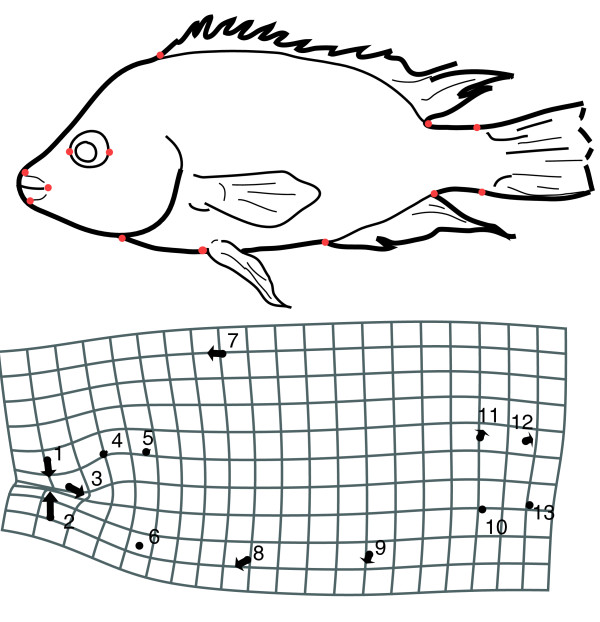
Body shape variation between thin-lipped and thick-lipped Apoyeque Midas cichlids. (a) The location of 13 landmarks to describe body shape. (b) Body shape differs significantly between thin- and thick-lipped fishes (P = 0.001). Here this is visualized (scale factor 4) as landmarks compared between the mean thick-lipped (circle; n = 36) and mean thin-lipped (arrow; n = 135) fishes. Body shapes remain different if the two landmarks describing lip thickness are excluded (P = 0.033) Body length does not differ between morphs (P = 0.34; see text for details).